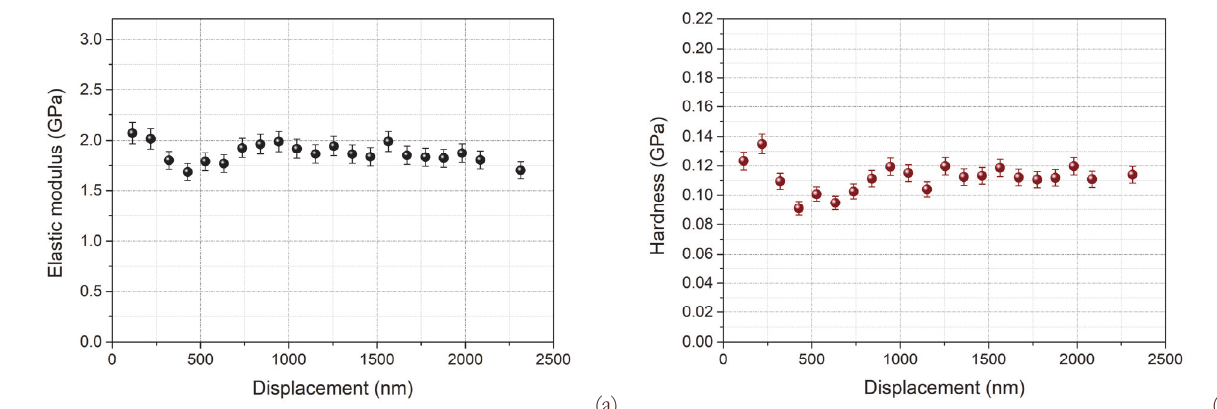
Figure 9: a) Elastic modulus and b) hardness values of the sample as a function of displacement, for MWCNT/PP 2 wt%